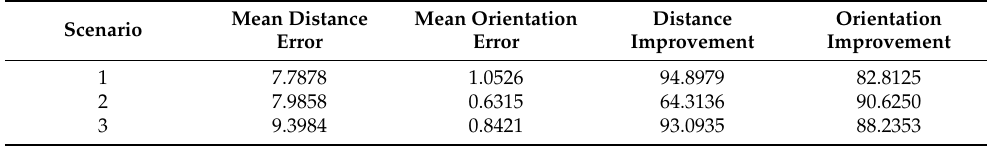
Table 2. Effect of environmental details on improving the position and orientation of the robot.